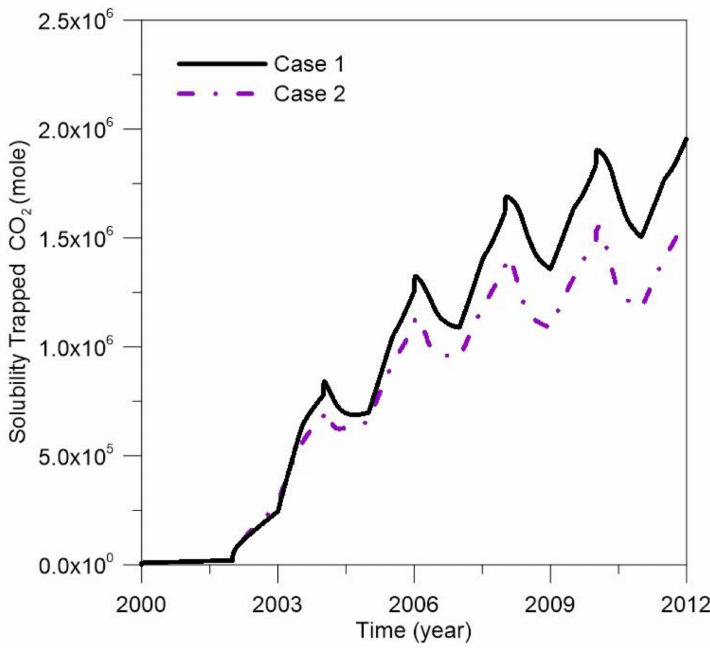
Figure 10. Solubility trapped CO 2 during CO 2 and impure CO 2 WAG injection.